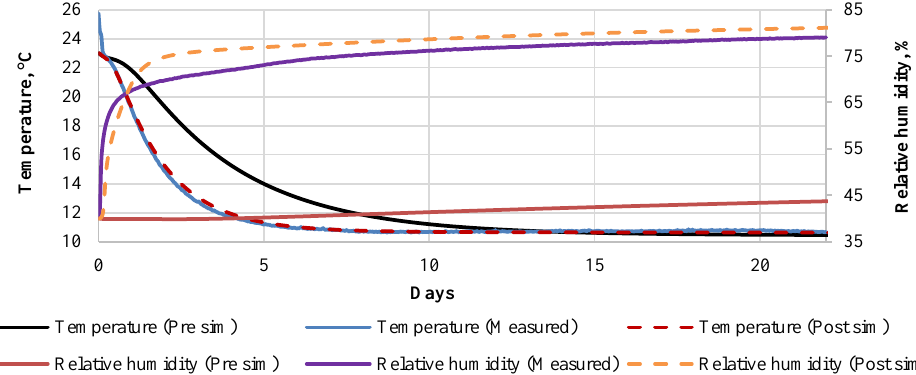
Fig. 10. Behaviour of temperature and relative humidity between masonry and EPS insulation layer: simulation before and after experiment, and measured results.